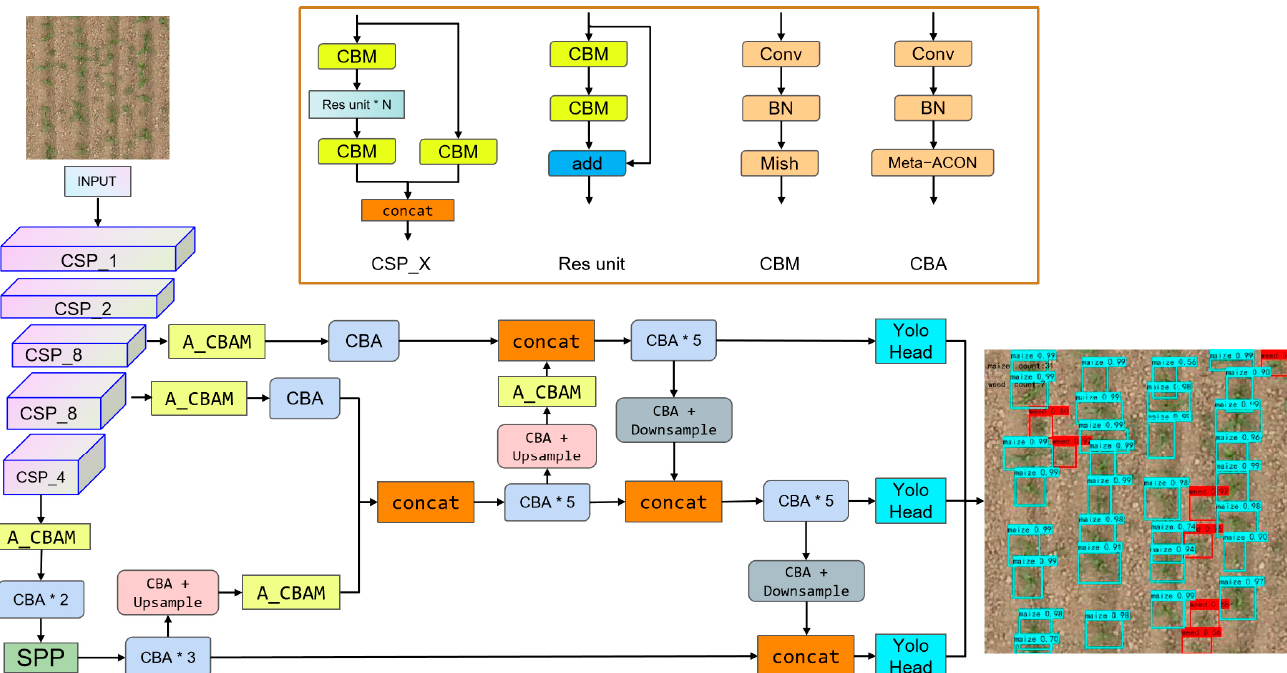
Figure 7. Improved YOLOv4 network structure